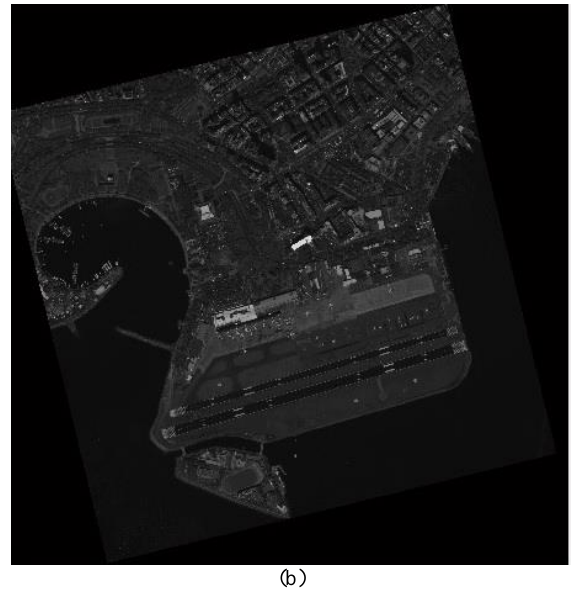
Figure 3. a) WorldView-2 image for test site, b) epipolar base image.